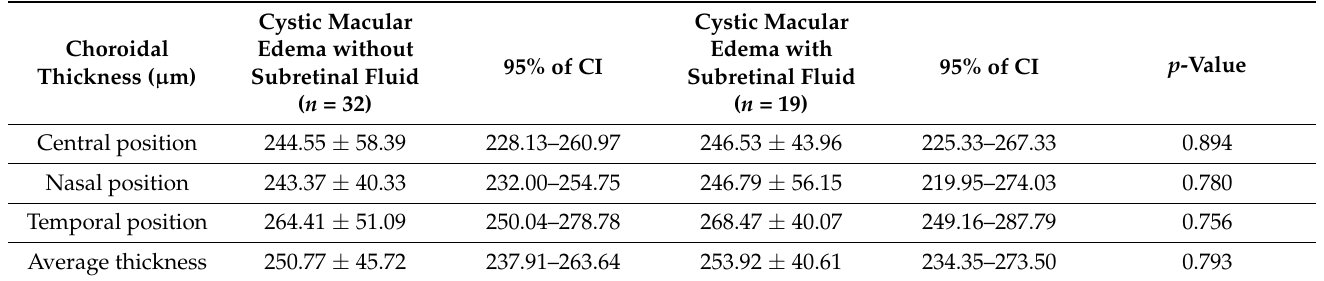
Table 2. Comparison of choroidal thickness measurements (by manual method) between cystic macular edema and cystic macular edema having subretinal fluid.